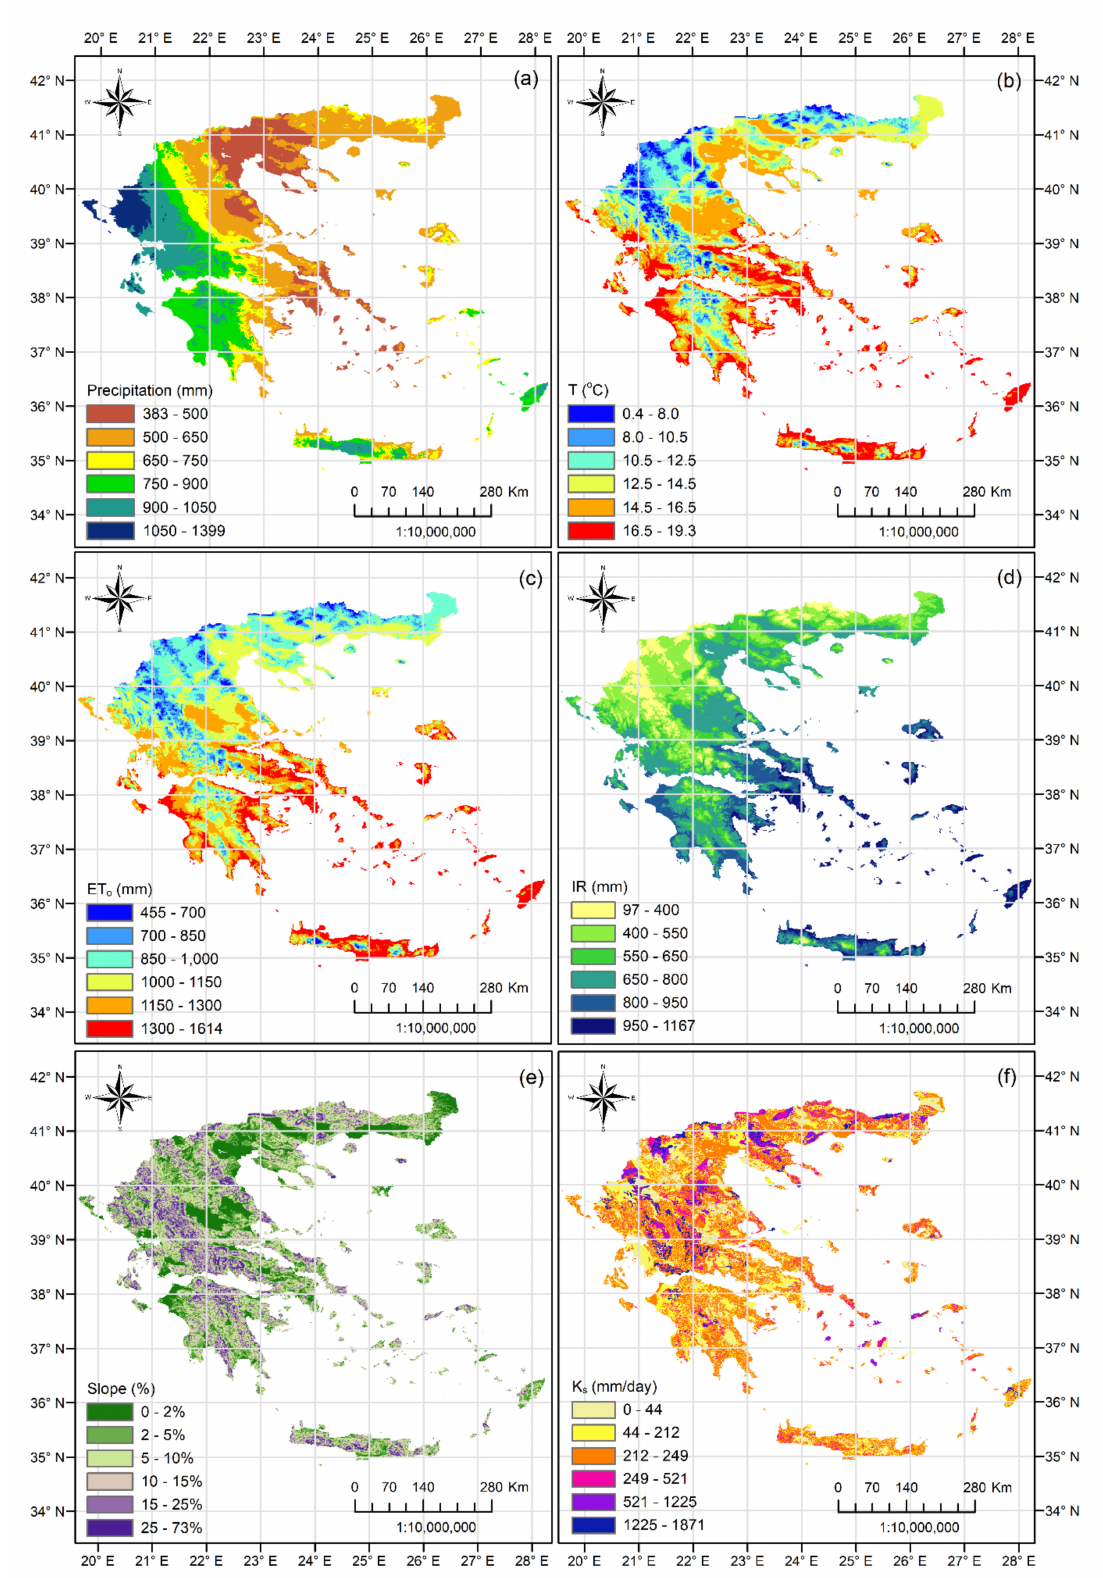
Figure 1. Mean annual values of ( a ) precipitation, ( b ) temperature, ( c ) reference evapotranspiration according to ASCE- standardized for short reference crops, ( d ) irrigation required for covering the deficit of annual reference evapotranspiration for the period 1950–2000, ( e ) surface slope and ( f ) saturated hydraulic conductivity in